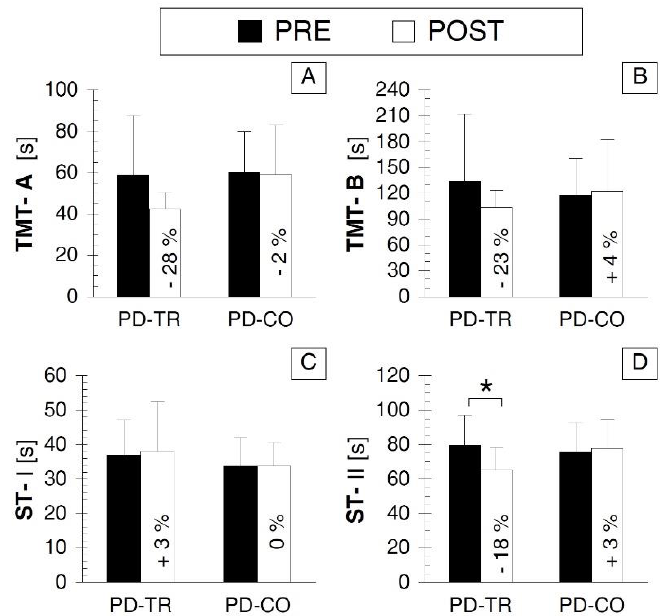
Figure 4. Comparison of psychological cognitive outcomes between the two testing sessions and the two tested groups. ( A ) panel A presenting the values of TMT-A; ( B ) panel B presenting the values of TMT-B; ( C ) panel C presenting the values of ST-I; ( D ) panel D presenting the values of ST-II.